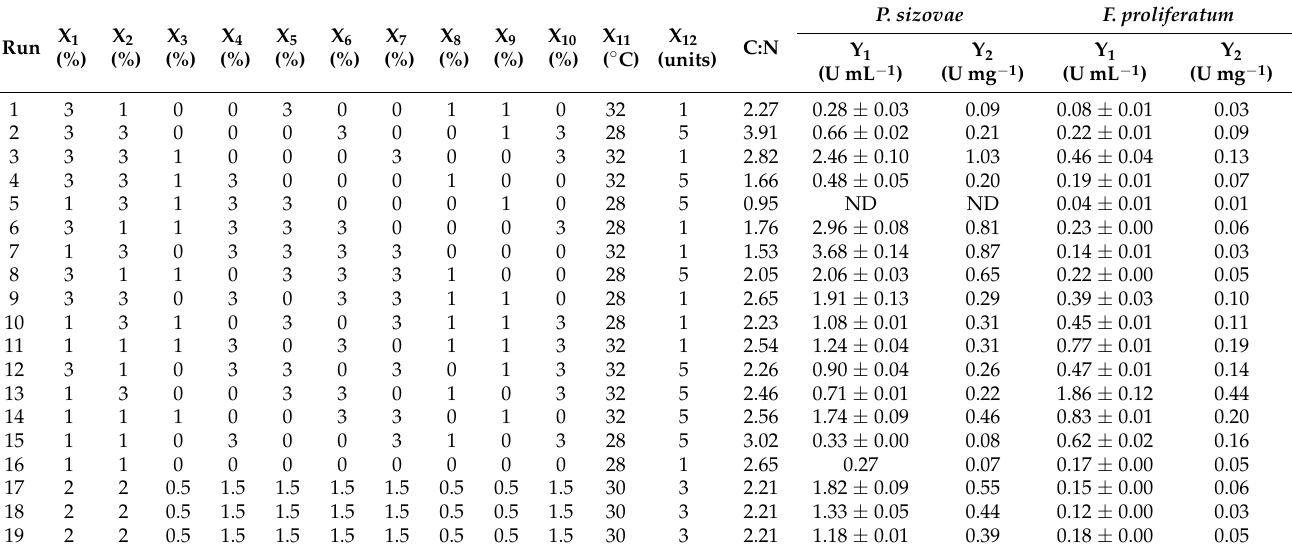
Table 2. Plackett–Burman experimental design matrix for the screening of variables for L -asparaginase activity (Y 1 ) and specific enzyme activity (Y 2 ) by P. sizovae and F. proliferatum